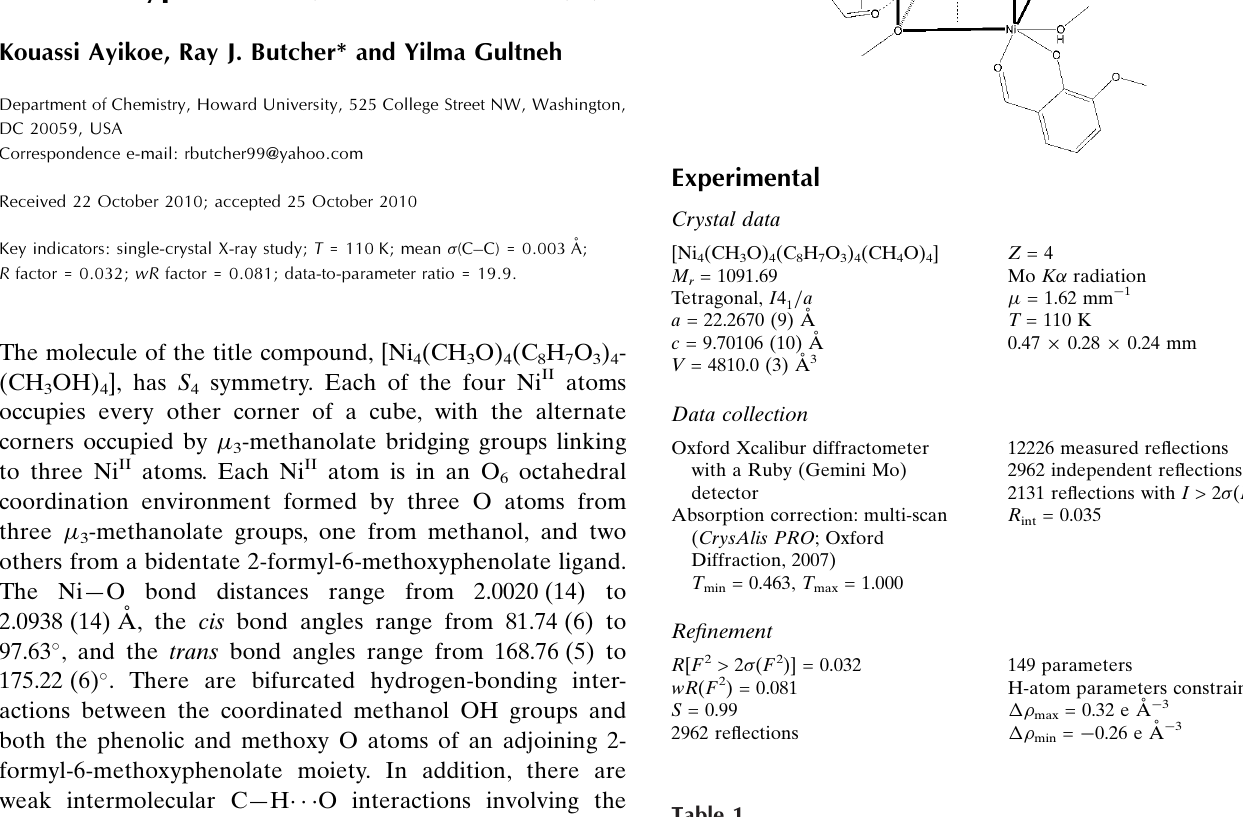
Hydrogen-bond geometry (A˚ , (cid:2)